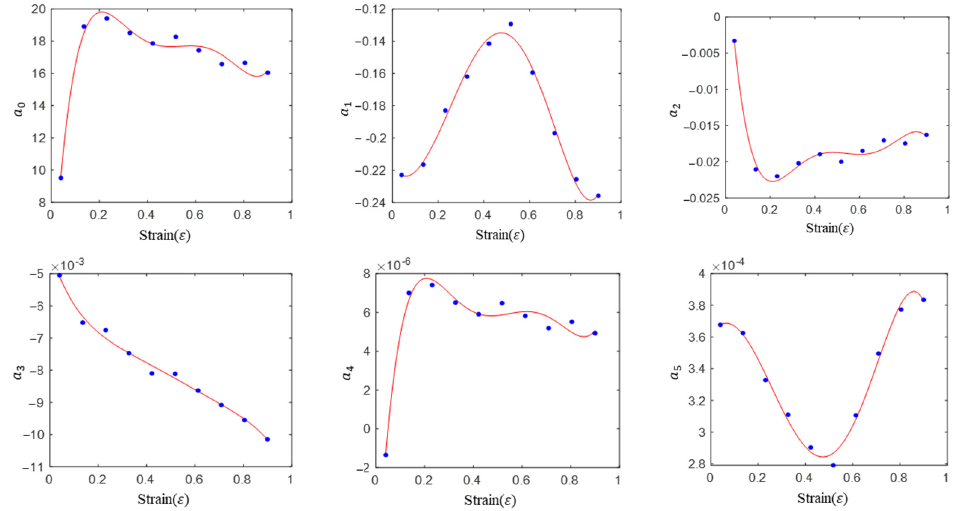
Figure 8. Linear regression values of material parameters at different strain levels and their polyno- mial fitting for the quadratic model.